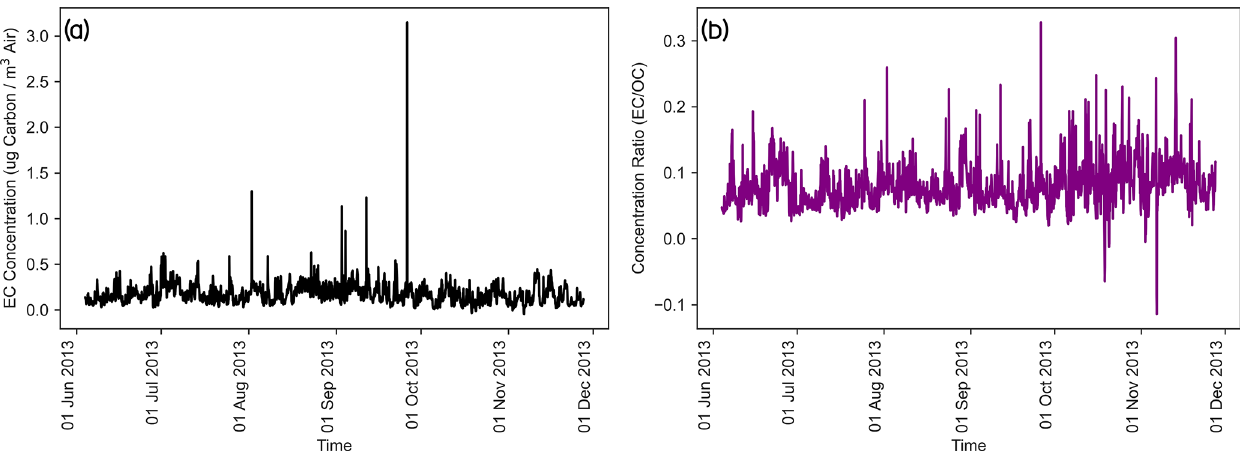
Figure A3. (a) Time series of elemental carbon (EC) concentration. (b) Time series of the ratio of EC and OC concentrations at SGP from June to November 2013.